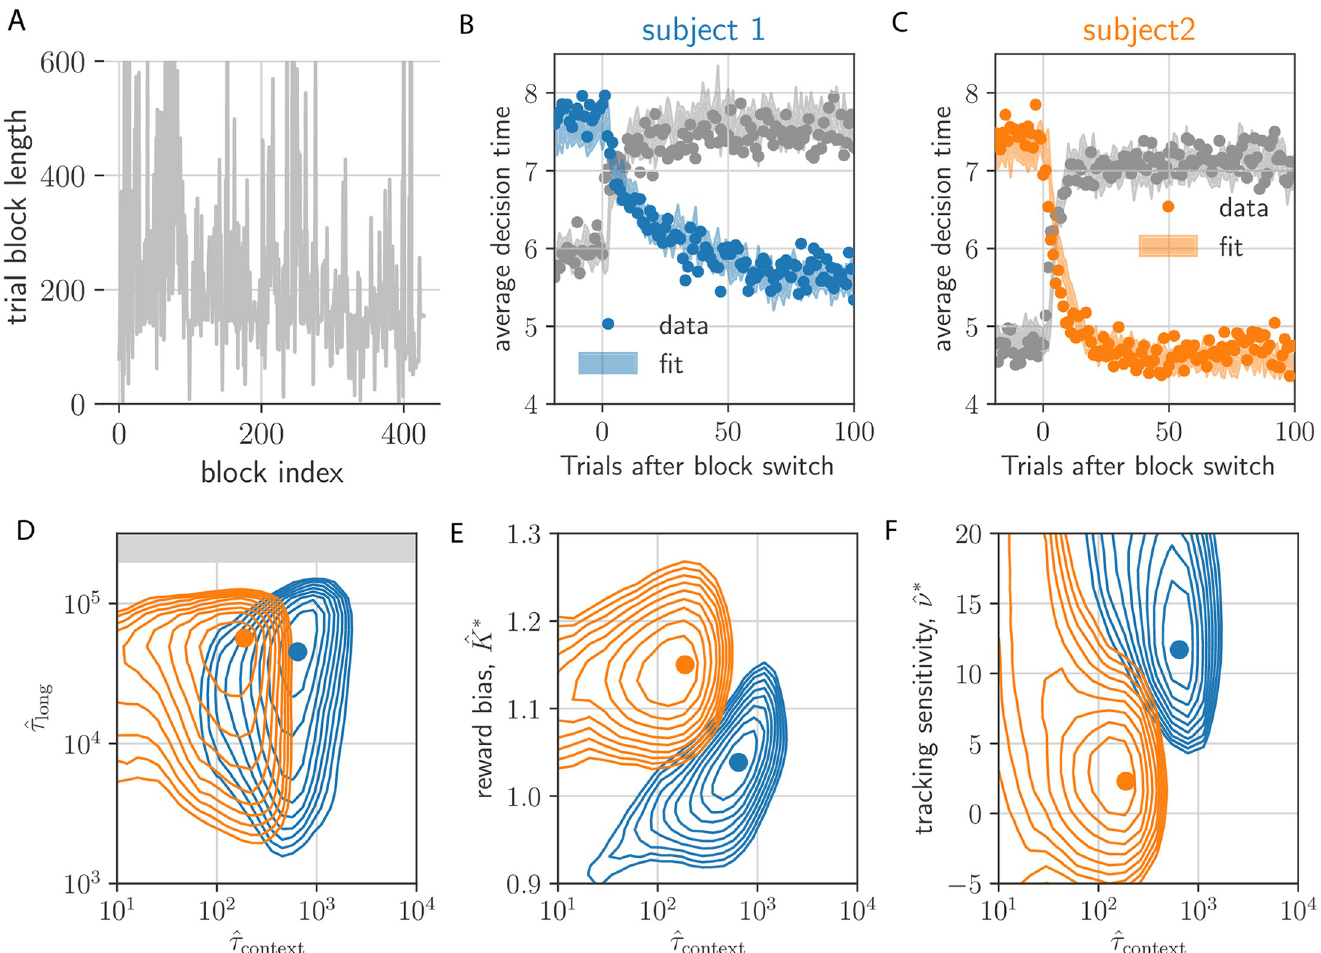
Fig 4. PGD model fit to NHP behaviour for non-stationary α -dynamics reported in Ref. [25]. (A) Block length sequence used in the experiment. (b,c) decision times (dots) aligned on the context-switching event type (fast-to-slow in gray; slow-to-fast in color) and averaged. Shaded regions are the standard error bounds of the models’ average decision times. (D) Error evaluated on a ð ^ t timescales within an order of magnitude of the end of the experiment). Contours show the first 10 contours incrementing by 0.01 error from the minimum (shown as a circle marker). Colors refer to subject, as in (B) and (C). (E) Same for ð ^ t